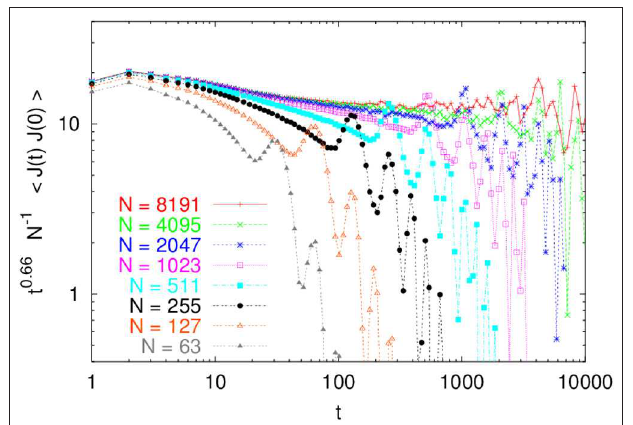
J ( t ) J (0) , in the h i 2.0 (adapted from = FIGURE 3 | Scaled perturbation profiles at times t 40,80,160,320,640,1,280,2,560, and 3,840, with γ 3 / 5. The profiles = = have been obtained by averaging over large number of realizations. In the inset, the profile at t 640 (solid line) is compared with the propagators of a = Lévy walk with an exponent ν 5 / 3 with a fixed velocity v 1 (dotted line) or = = with velocity chosen from a Gaussian distribution with mean 1 and variance 0.036 (dashed line) (adapted from Cipriani et al. with permission from [8] Copyright (2005) by American Physical